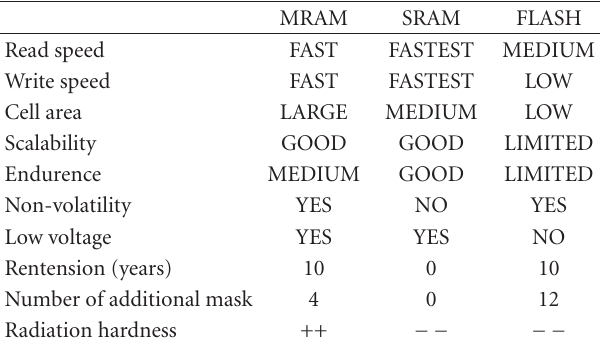
Figure 1: RSRAM cell based on the unbalanced flip-flop [12]. Table 1: Memories performance